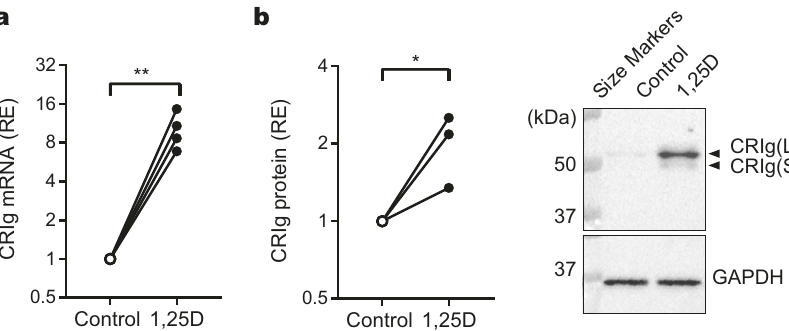
Fig. 3 Effects of treating the macrophages directly with 1,25D on CRIg expression. a Macrophages matured after 3 days of monocyte culture, were treated for a further 24 h with 100 nM of 1,25D or diluent and then the CRIg mRNA levels measured by qPCR. Data are expressed as CRIg relative to GAPDH from four experiments, each conducted with cells from a different individual. b Macrophages differentiated from culturing monocyte for 5 days culture, were treated as described above. The CRIg expression was measured by western blot in three experiments, each conducted with cells from different individuals. A representative western blot is shown of CRIg and GAPDH staining of the same blot. a , b Relative expression (RE) of mRNA or protein was measured against GAPDH. P values were calculated by paired, one-tailed Student ’ s t -test. Signi fi cance of differences between 1,25D versus control, * P < 0.05; ** P < 0.01.